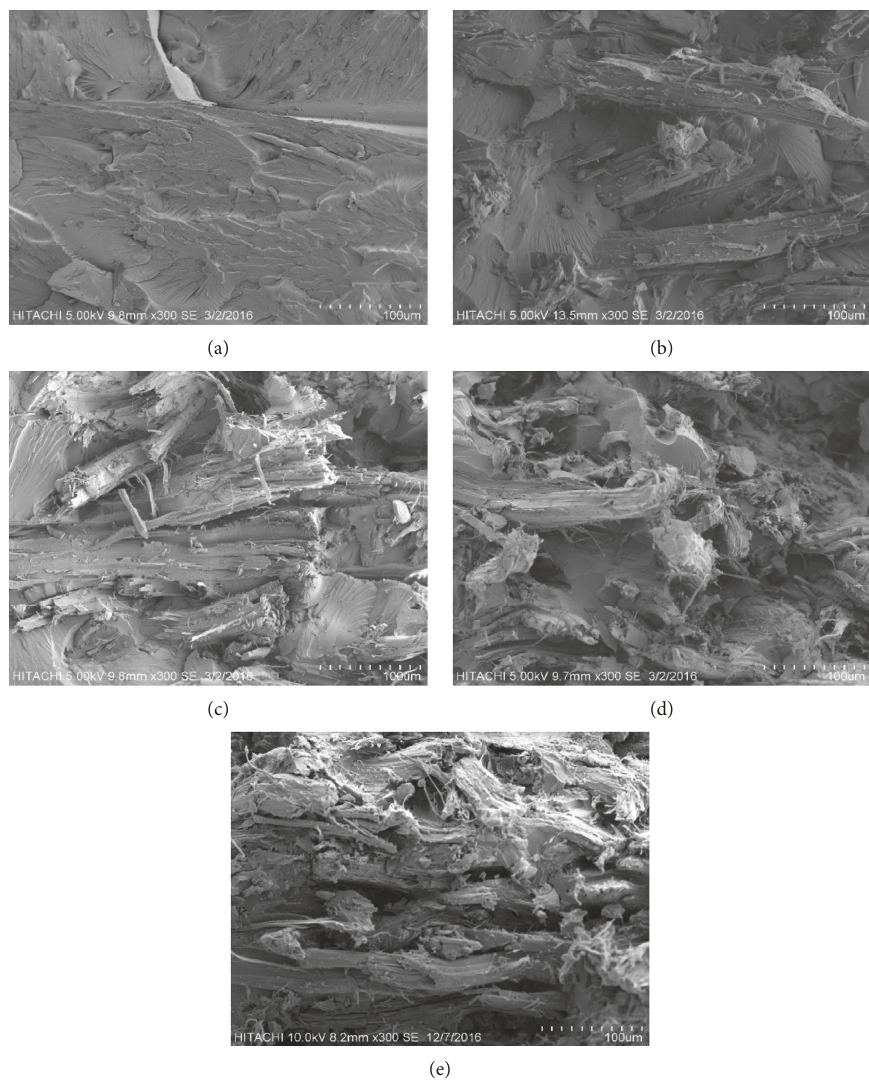
Figure 3: SEM image of the specimen tensile rupture surface. (a) 100CL. (b) 30UTK. (c) 40UTK. (d) 50UTK. (e) 60UTK.